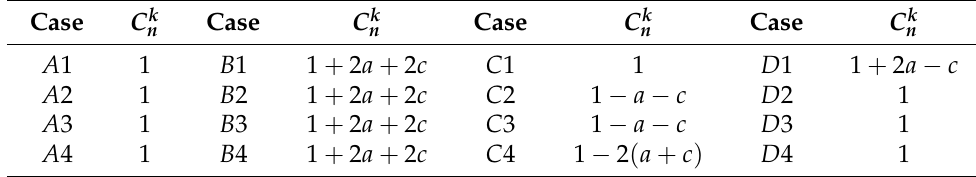
Table A1. Values of C k n for the cases A , B , C and D considered in the